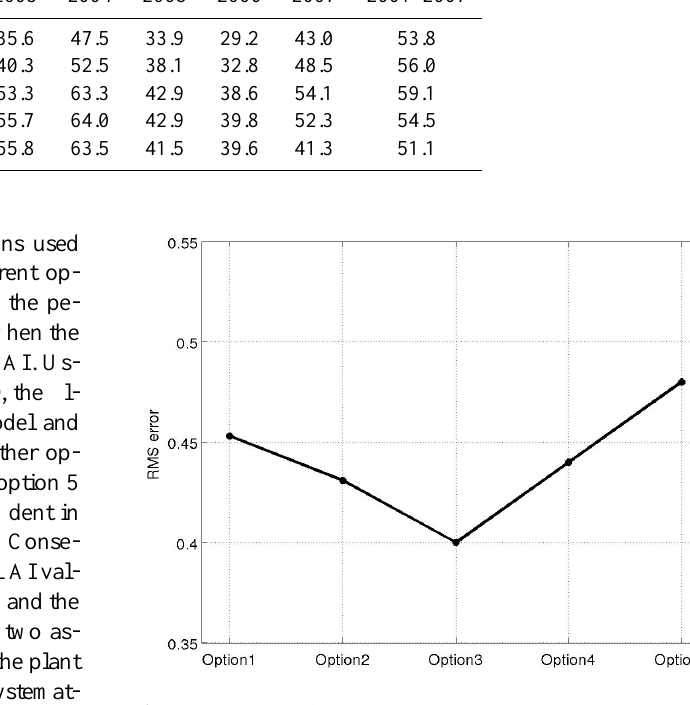
Fig. 6. Evolution of the LAI rms error as a function of choices of error std: option 1 ( σ LAI ∝ LAI), option 2 ( σ LAI = 0 . 2 for LAI < 1), option 3 ( σ LAI = 0 . 4 for LAI < 2), option 4 ( σ LAI = 0 . 6 for LAI < 3) and option 5 ( σ LAI = 1). The rms error is calculated using all available